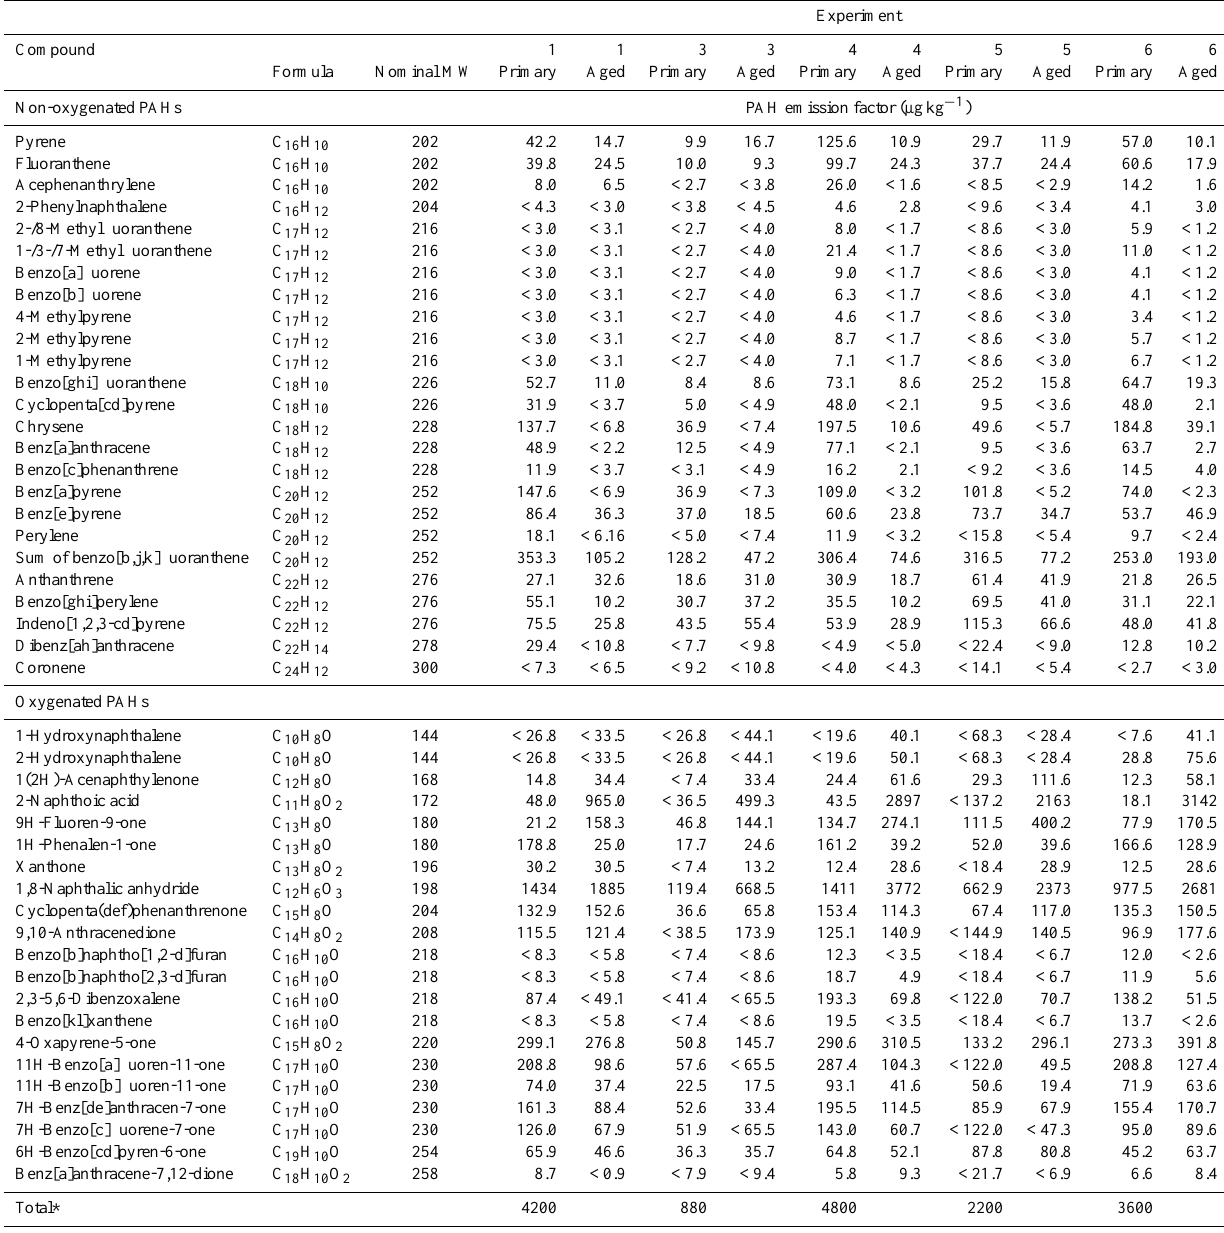
Table 3. PAHs quantified from offline GC-MS analysis of filter